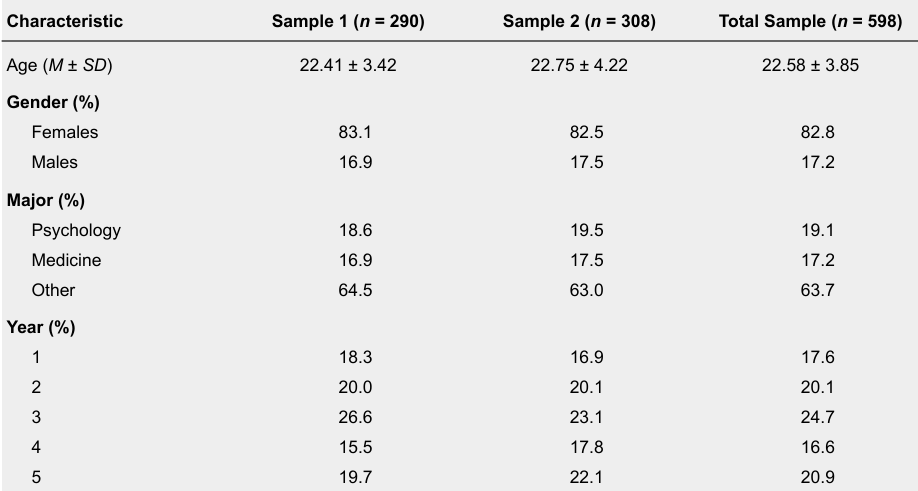
Socio-Demographic Characteristics of the Two Samples and Total